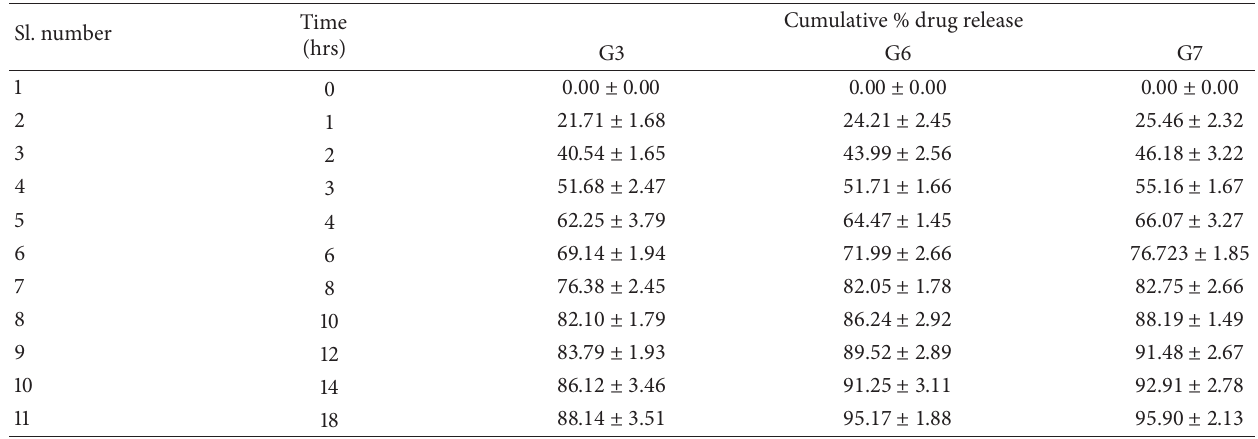
Table 5: Effect of stirring rate on drug release in 0.1N